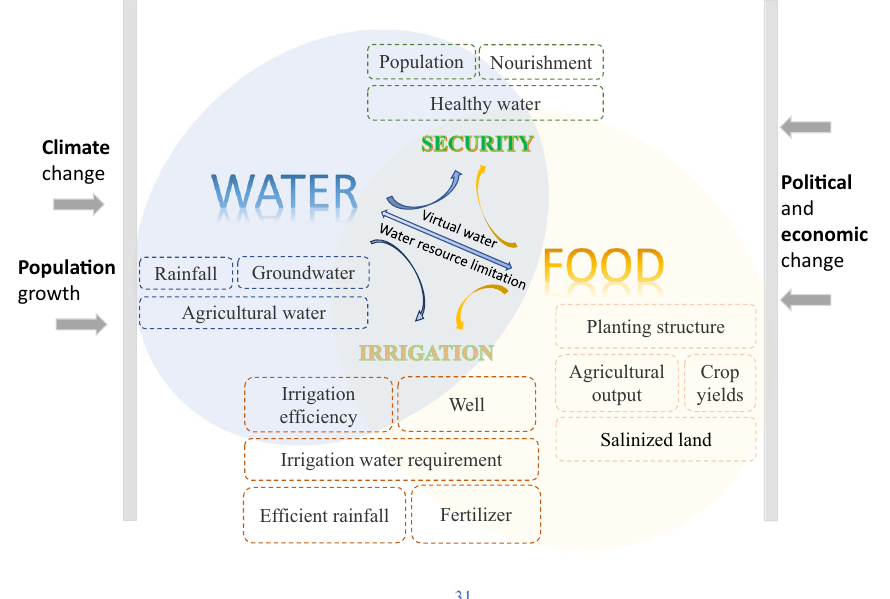
Figure 7. Schematic diagram of the Bayesian network